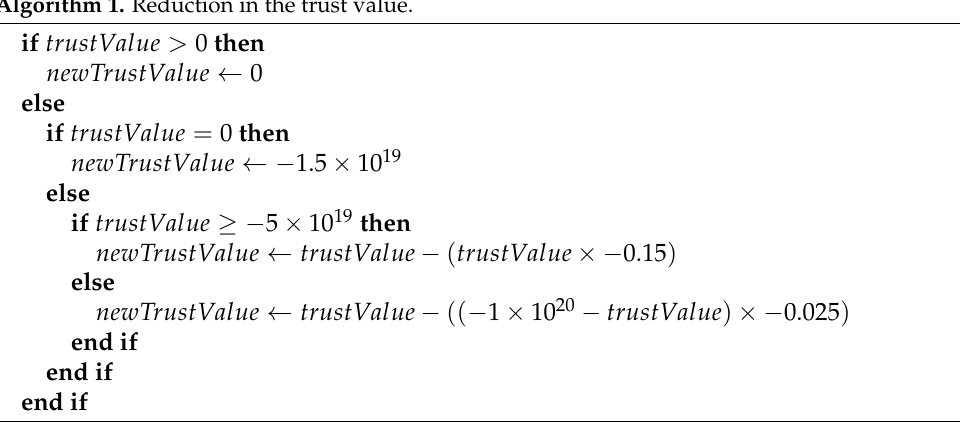
Algorithm 1. Reduction in the trust